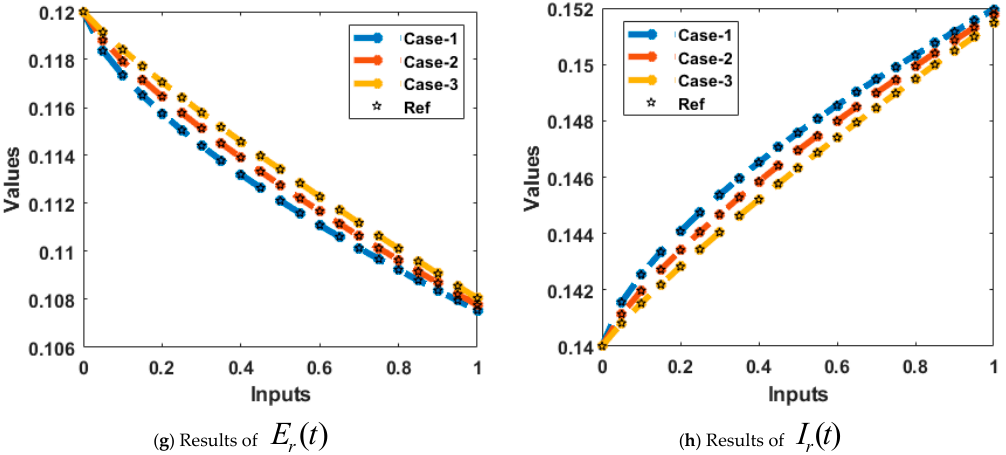
Figure 6. Performances of the results to solve the fractional monkeypox model.